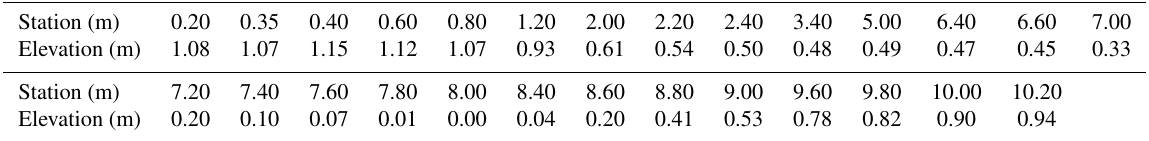
Table A2. Cross section for the Ritobacken Brook. Original data collected by Västilä et al.